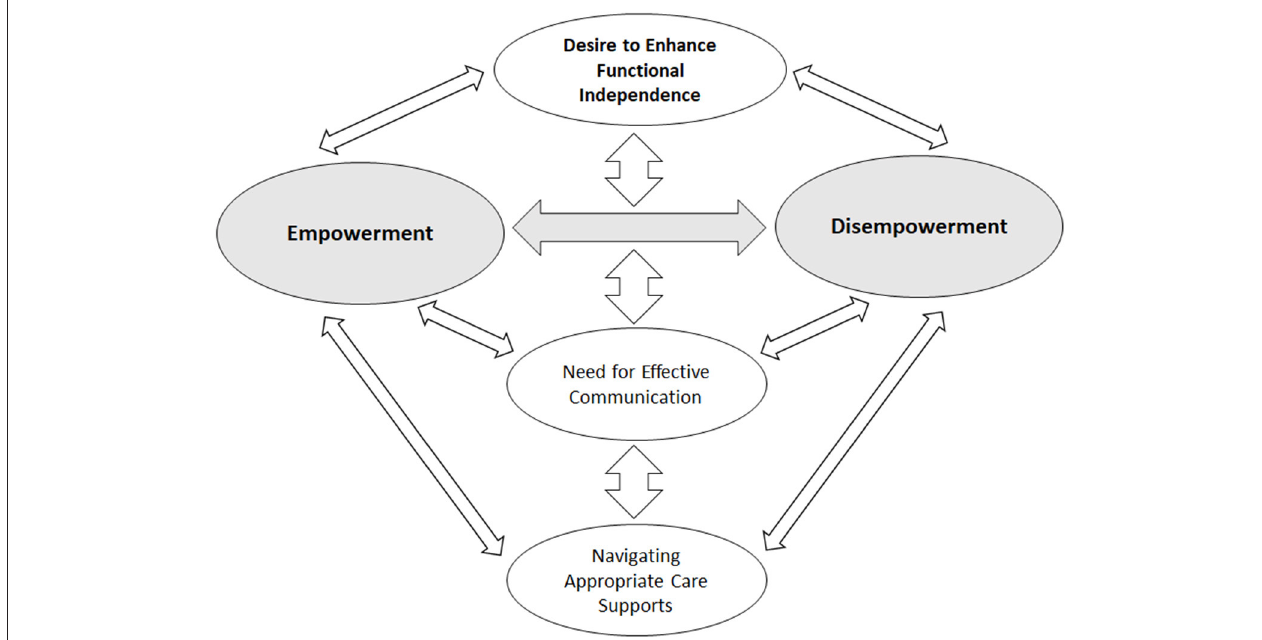
FIGURE 1 | Thematic framework underlying the experience of persons with SCI regarding in-hospital care.